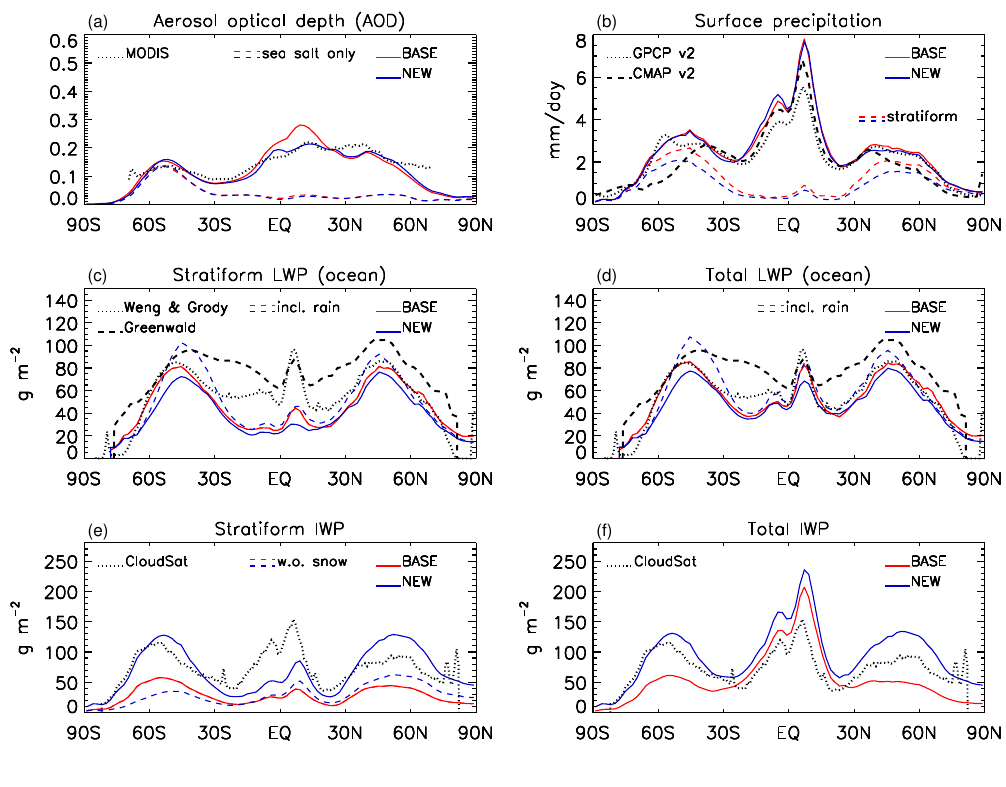
Fig. 2. Zonal mean model results and observations (see caption to Table 2). Dashed lines in (a) are simulated AOD due to sea-salt only for the BASE (red) and the NEW run (blue); (b) includes an additional precipitation estimate from CMAP (Xie and Arkin, 1997) Version 2. Dashed lines in (b) denote contributions from the stratiform cloud scheme. Total LWP and IWP in (d) and (f) include contributions from convective clouds. Snow is diagnosed separately only in the NEW scheme. The dashed blue line in (e) does not include contributions from snow, while the solid blue lines in (e) and (f) do.